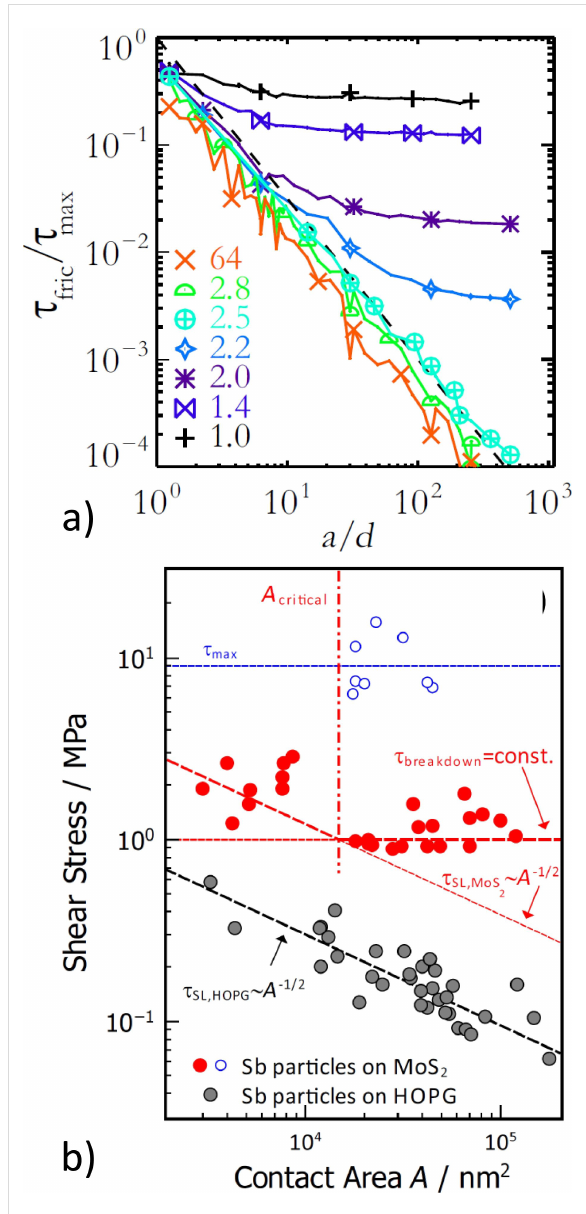
Figure 3: Dependence of nanoparticle shear stress on the contact area. a) Relative shear stress obtained from MD simulations as a func- tion of the particle radii normalized by the lattice constant d . Calcula- tions have been performed for different shear moduli G of the particles: low values of G result in a saturation of the shear stress. Reprinted with permission from [101], copyright 2016 American Physical Society. b) Experimental data obtained for Sb nanoparticles sliding on HOPG (gray) and MoS 2 (red). While a constant decrease of shear stress with particle size is observed for the HOPG substrate, a saturating shear stress is found on MoS 2 . Reprinted with permission from [100], copy- right 2017 American Chemical